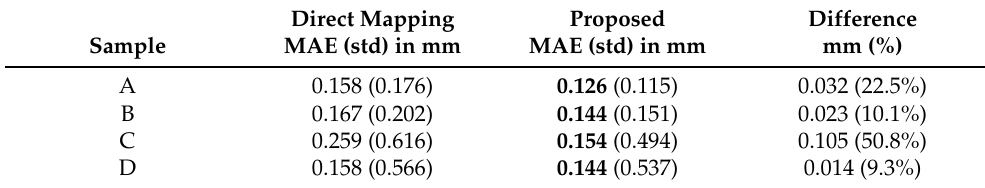
Table 3. Compared MAE (and standard deviation) of the direct mapping versus the proposed virtual reference method with 2D Itoh’s unwrapping algorithm. The last column reports the absolute and percentage difference.